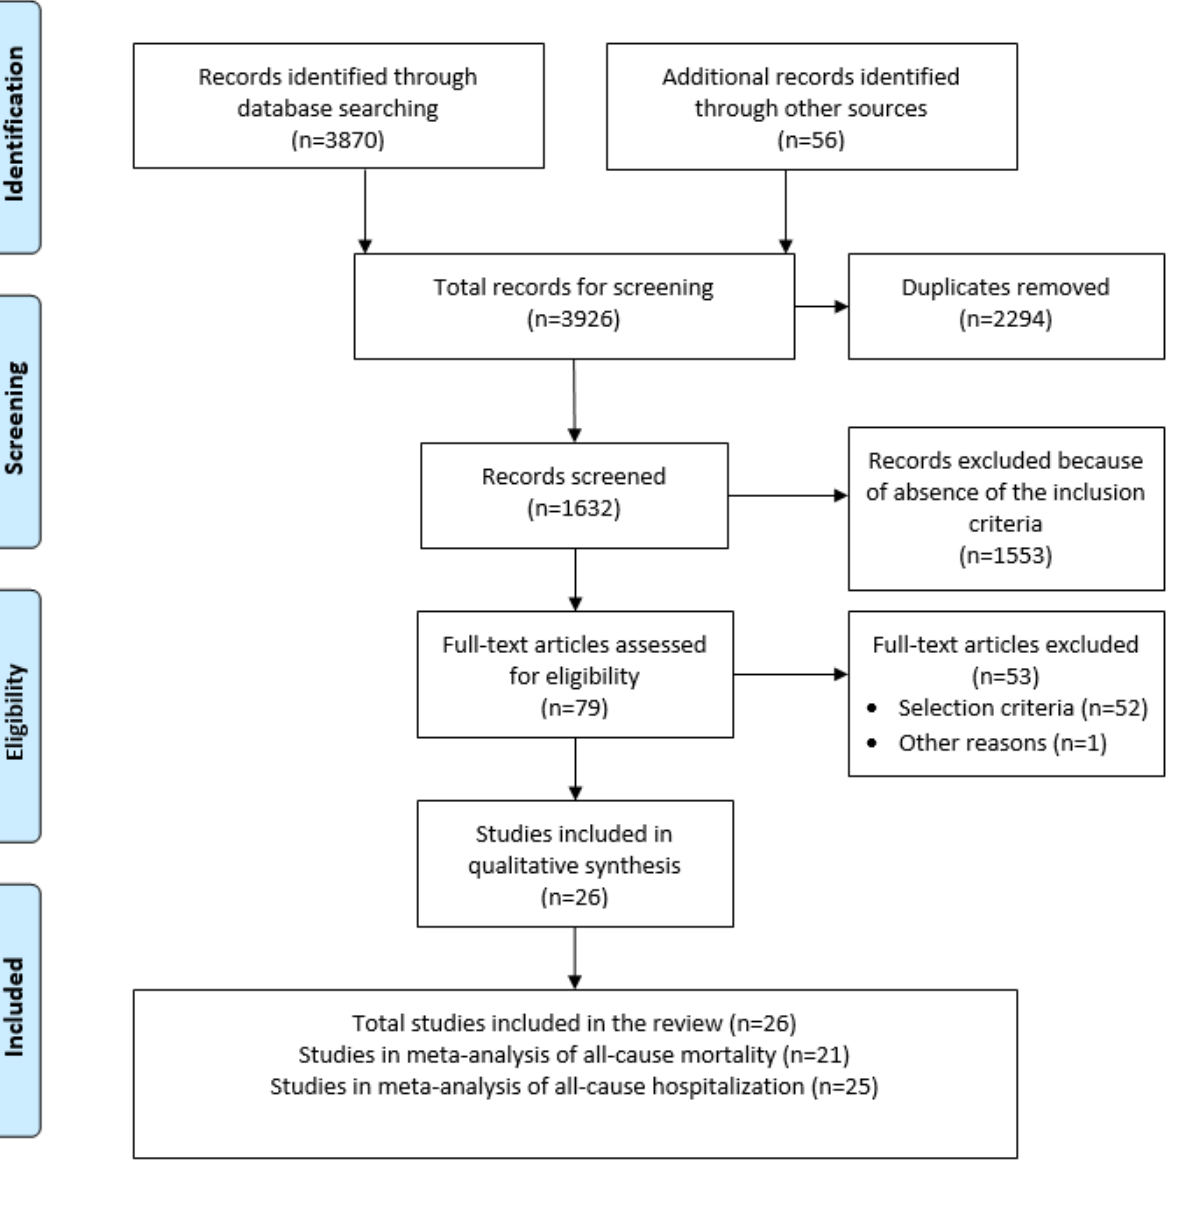
Figure 1. Flow diagram of study selection.